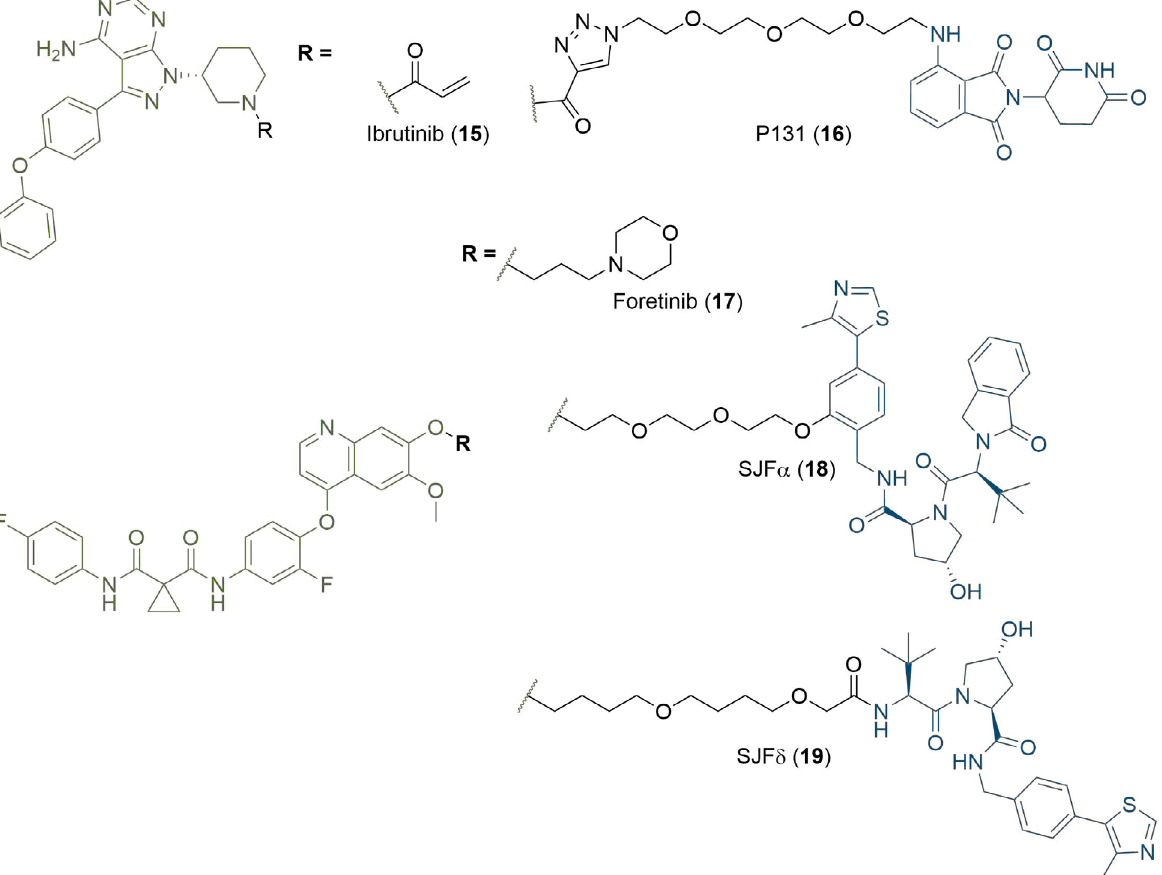
Figure 5. Structure of the BTK covalent inhibitor ibrutinib (15) and its PROTAC counterpart P131 (16), a potent degrader of WT and C481S mutant BTK. Promiscuous kinase inhibitor foretinib (17) is incorporated into PROTAC degraders of MAPK kinases, which differ by linker composition and site of conjugation to the VHL ligand. SJFα (18) is selective for p38α and SJFδ (19) for p38δ. In all PROTACs, the anchor is coloured blue and the warhead